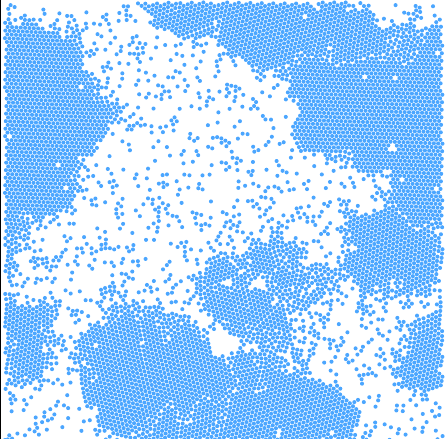
FIG. 1. Snapshot of particles subjected to a disordered drive. A phase separation emerges which is analogous to the motility- induced phase separation of active particles [13,26]. Simulation details are in the Appendix A and the movie in Ref.